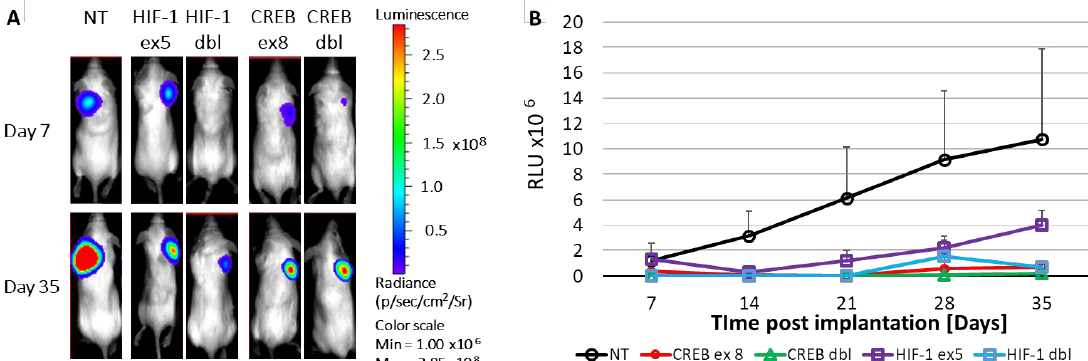
Figure 5. The role of CREB and HIF-1 in tumor progression. Mice ( n = 5 in each group) were injected subcutaneously with 4 × 10 6 Mel270 UM cells stably expressing the luc gene and either of the shRNAs targeting CREB or HIF-1 via a single or a double shRNA expressing RCRs. Cells expressing the non-target (NT) shRNA sequence served as control. Tumor growth was monitored via bioluminescence as previously described [16]. ( A ) A representative mouse from each group is depicted at day 7 and day 35 post transplantation. ( B ) Kinetics of growth of the UM tumors infected by the various armed viruses expressed by relative light units (RLU). The growth rate of tumors infected with vACE NT is significantly greater than that each of all the other armed viruses ( p < 0.0001 for each comparison and for the entire model).